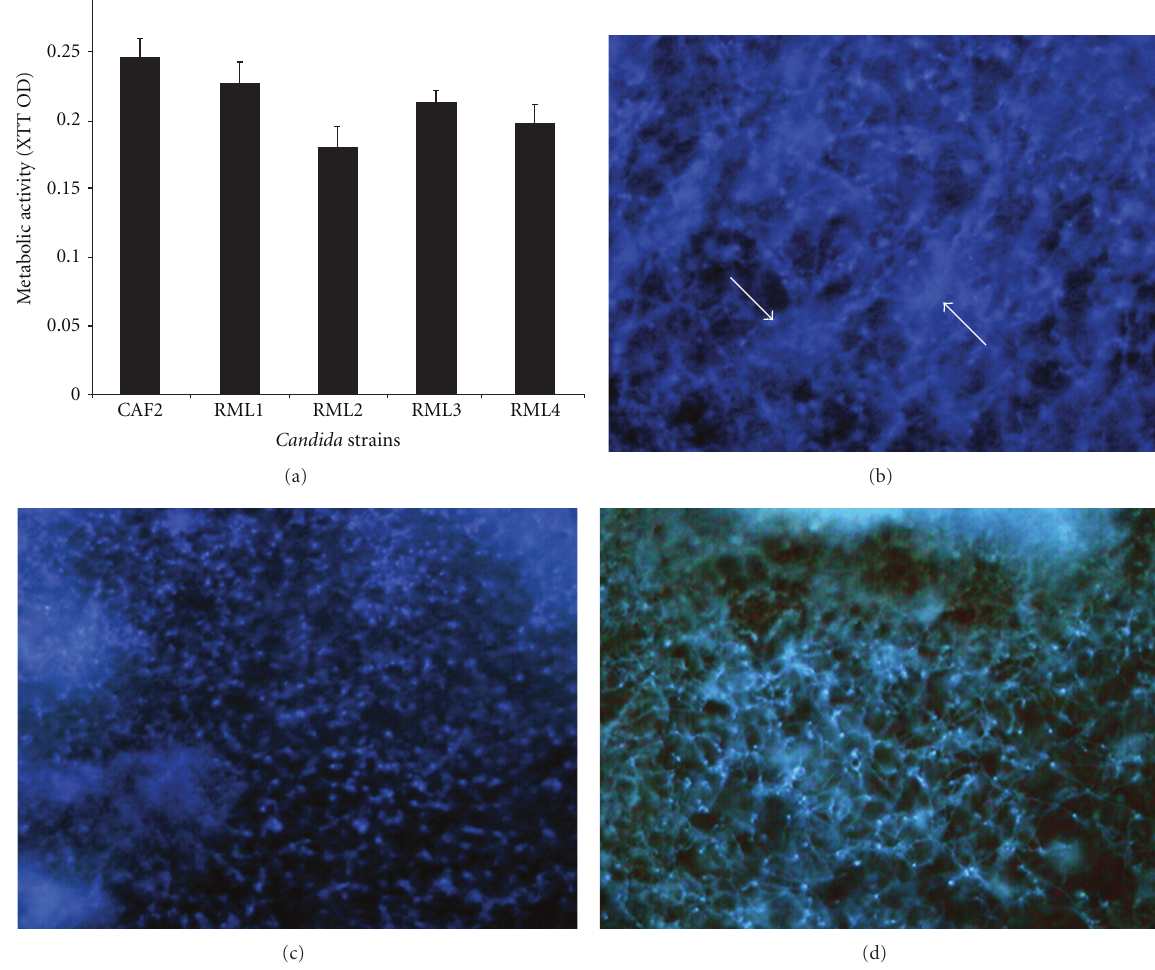
Figure 1: Biofilm-forming ability of isogenic wild-type, Caecm33 mutant, and revertant strains. (a) Metabolic activity of mature biofilms formed by the isogenic strains. (b–d) Fluorescence micrographs showing di ff erences in morphology of biofilms formed by (b) wild-type, (c) ECM33 mutant, or (d) revertant strain. RML1-heterozygous Caecm33/CaECM33 mutant; RML2-homozygous Caecm33 mutant; RML3- heterozygous Caecm33/CaECM33 revertant; RML4-homozygous ECM33/ECM33